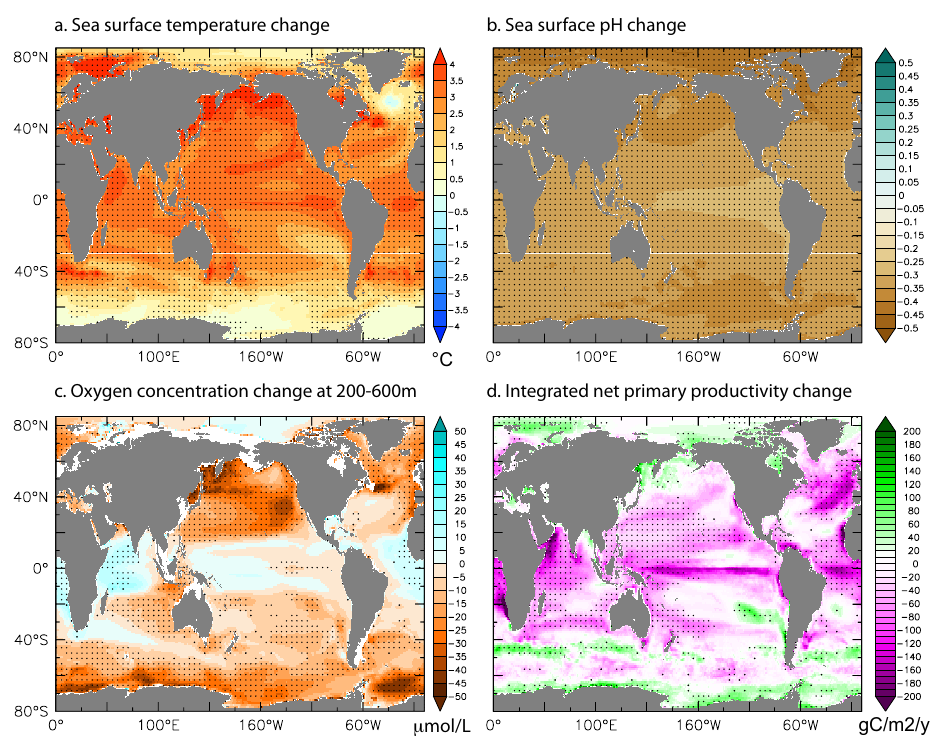
Fig. 5. Change in stressor intensity (defined as the change in the magnitude of the considered variable) in 2090–2099 relative to 1990–1999 under RCP8.5. Multi-model mean of (a) sea surface warming ( ◦ C), (b) surface pH change (pH unit), (c) subsurface dissolved O 2 con- centration change (averaged between 200 and 600m,mmolm − 3 ) , and (d) vertically integrated NPP (gCm − 2 yr − 1 ) . Stippling marks high robustness. Robustness is estimated from inter-model standard deviation for SST and pH, from agreement on sign of changes for O 2 and NPP. Dark red color shading is used to mark the change in stressor that is detrimental for the marine environment.